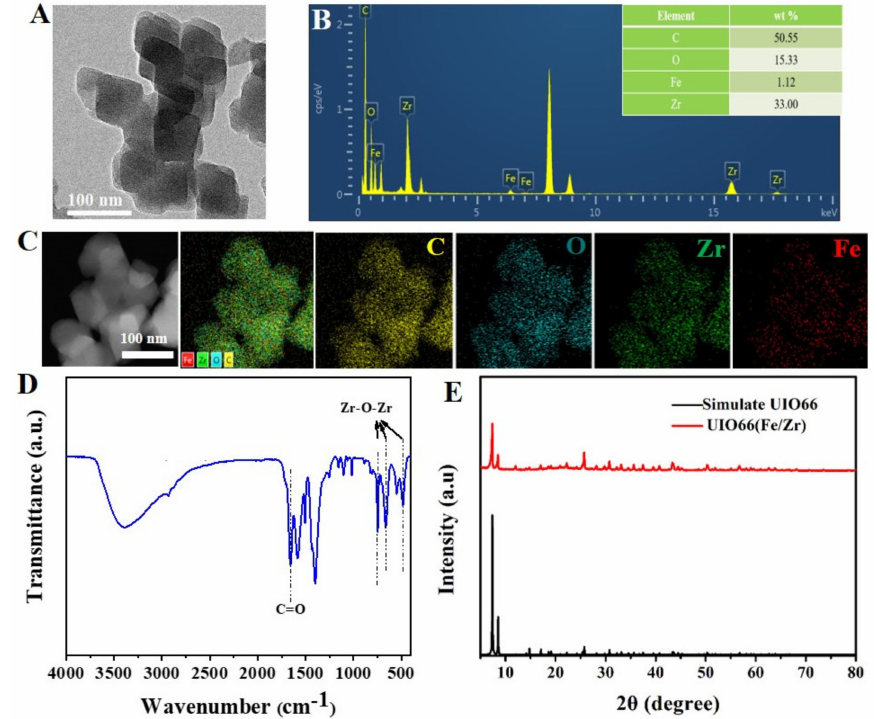
Figure 2. ( A ) Transmission electron microscopy (TEM) image, ( B ) elemental analysis, ( C ) EDS images, and ( D ) FT-IR spectrum of the prepared UIO-66(Fe/Zr). The inset shows the corresponding percentage of elements C, O, Fe, and Zr. ( E ) XRD patterns of the prepared UIO-66(Fe/Zr) and simulate